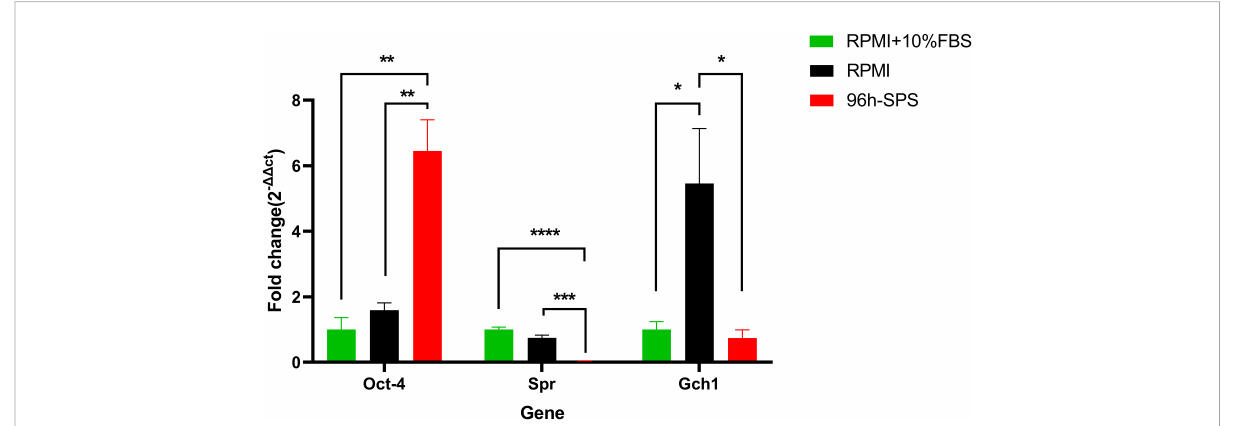
FIGURE 3 Gene expression of Spr , Gch1 , and Oct 4 in LA7 cells exposed to complete medium (RPMI + 10% FBS), RPMI, and 96 h-SPS in vitro . Gapdh was considered as an internal control. In comparison with two other solutions, 96 h-SPS – treated cells upregulated the Oct-4 gene expression, p< 0.01. However, this solution was signi fi cantly able to downregulate the Spr gene expression when compared with complete medium, p< 0.0001, and RPMI groups, p< 0.001. Data expressed as mean ± SD, bars indicate the SD. In each panel. * p < 0.05, ** p < 0.01, *** p < 0.001, and **** p <